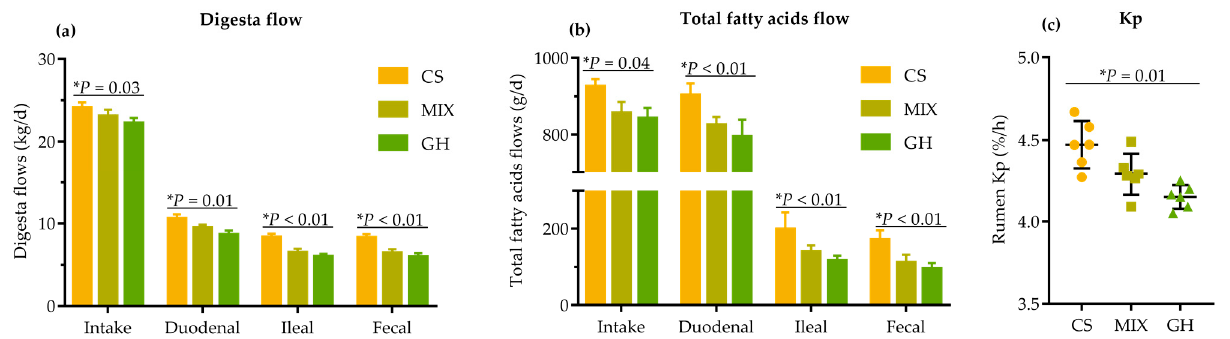
Figure 1. Effects of different dietary forage sources on ( a ) digesta flow (DM) across the GIT; ( b ) total fatty acids flow across the GIT; ( c ) Kp through the rumen of cows. The bars indicate the standard deviation, * represents the linear effect of corn silage proportion in diets.